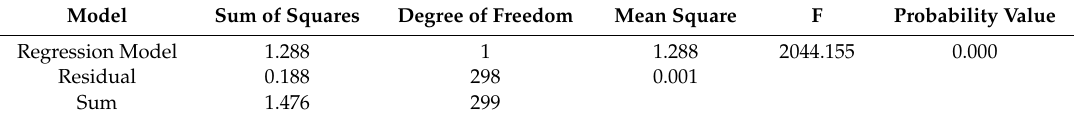
Table 3. The Analysis of Variance between Ship Capacity (TEU) and Ship Length